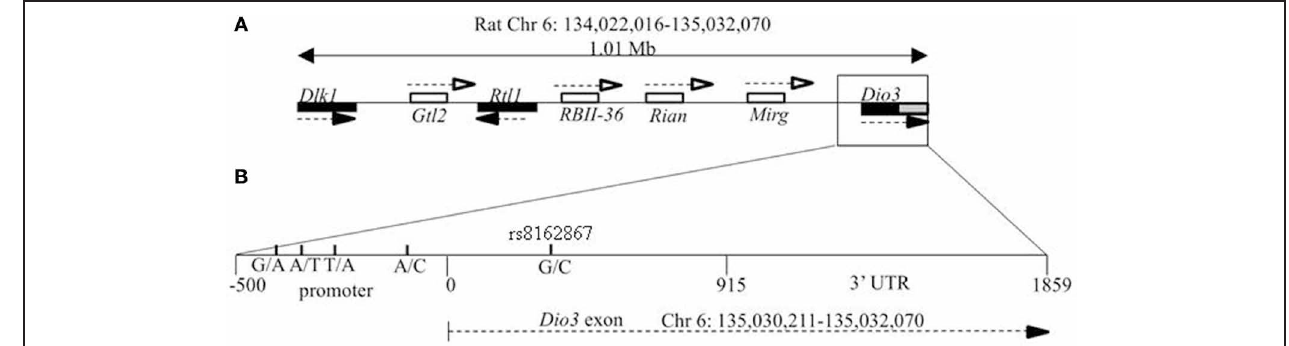
subregion which was sequenced for polymorphisms between BN vs. LE and SD strains. Four polymorphisms were found within the high-GC promoter region ( − 500 to 0) proximal to the Dio3 start site (0). A synonymous G/C SNP in the Dio3 exon (342) allows determination of paternal/maternal allelic expression. Chromosomal bp location of the Dio3 transcript is given below. Location of genes and non-coding transcripts are not to scale.